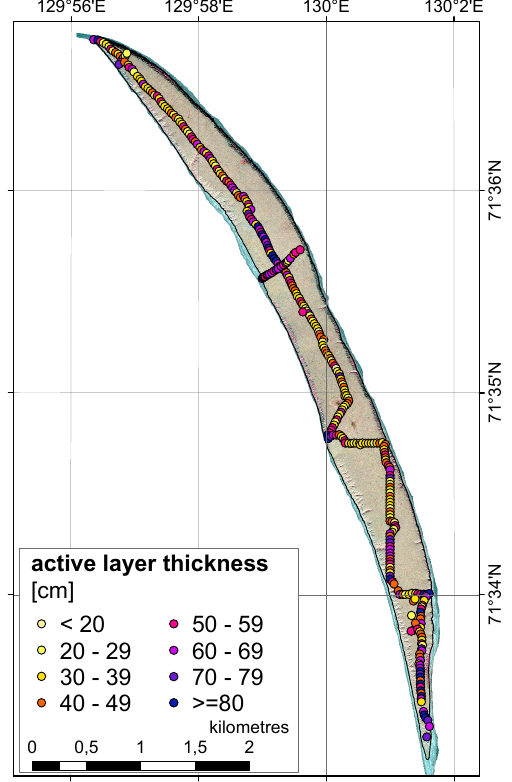
Figure 4. Map showing locations of active layer thickness mea- surements on Muostakh made during field work in August 2012. Sampling points were classified and colour coded in steps of 10cm. 2012 GeoEye image as